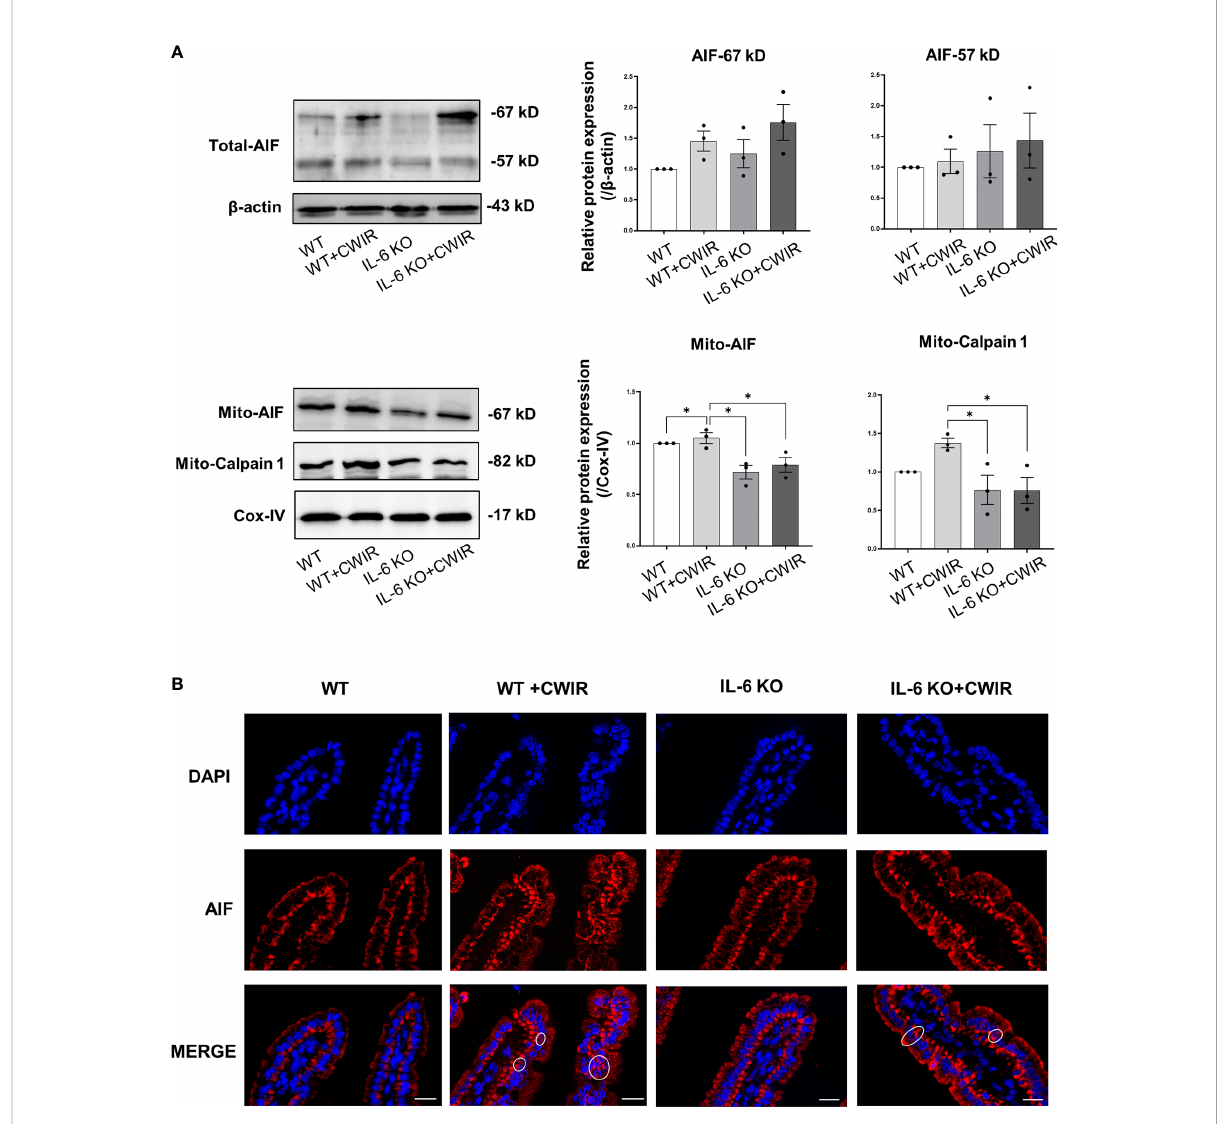
FIGURE 7 IL-6 KO signi fi cantly altered the mitochondria AIF signaling after acute CWIR rather than caspases. (A), Western blot images and quanti fi cation of total AIF, mitochondrial AIF, and calpain 1 in the intestinal epithelium within the four groups. Data analysis was performed by two-way ANOVA with the Tukey post-hoc test. N=3, *P < 0.05. (B), Representative immuno fl uorescence images of AIF (red) and DAPI (blue) in the jejunal epithelium. Double staining of AIF and DAPI was circled. The scale bar represents 20 m m.